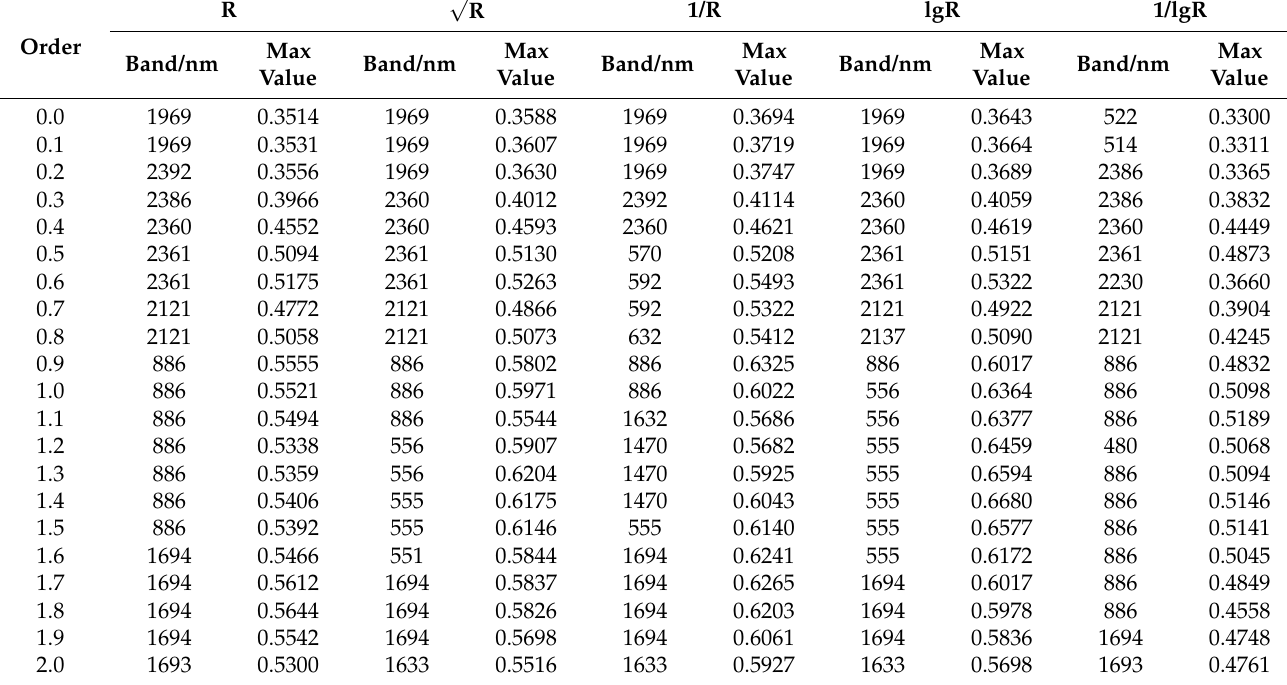
Table 6. The absolute value of the maximum correlation coefficient between the hyperspectral and Na + in Area C and its corresponding